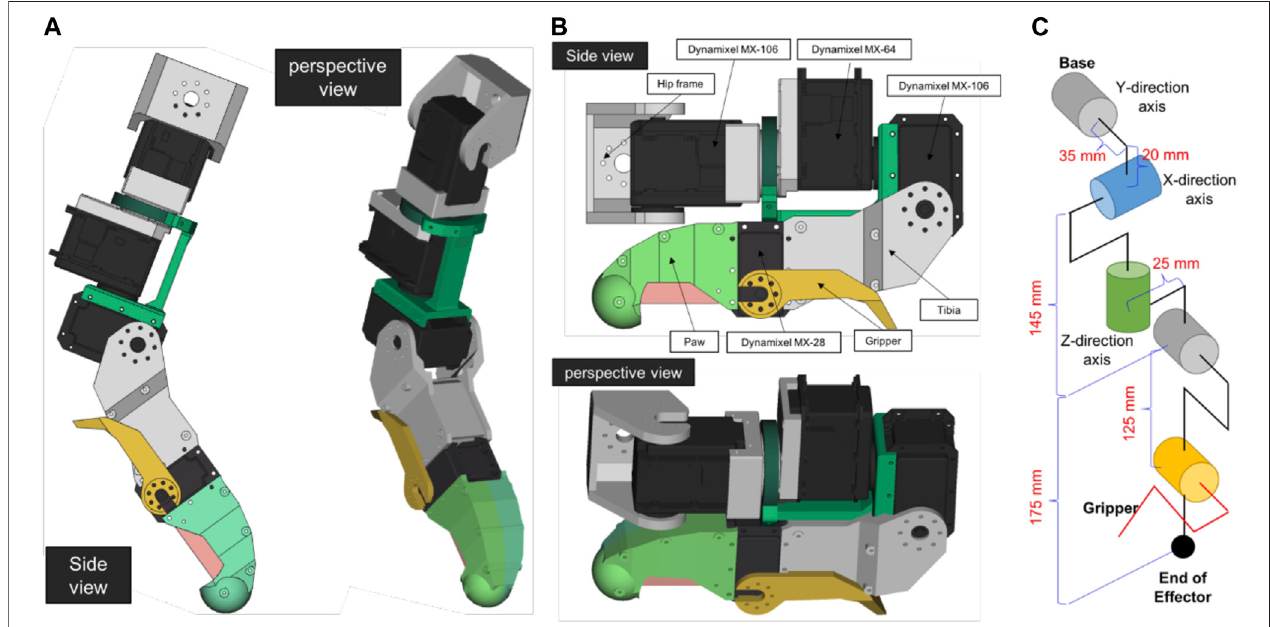
FIGURE 3 | The design of Leg (A) fl exed, (B) extended. (C) Leg actualization.